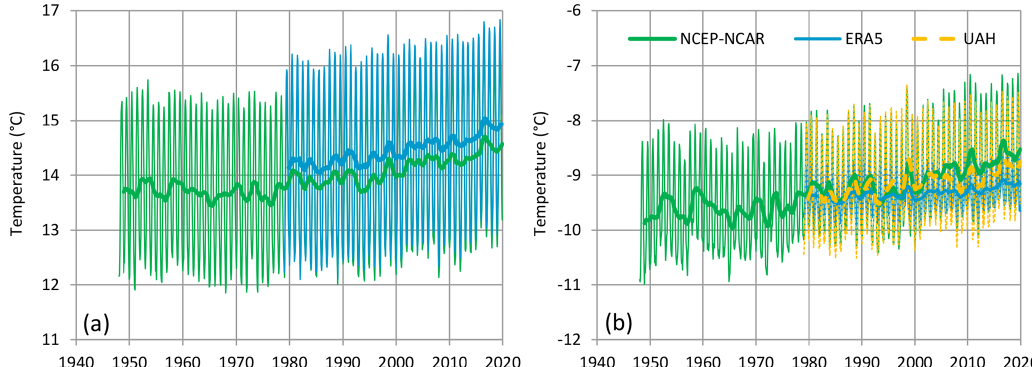
Figure 1. Variation of the global average temperature (a) at the level of 2m above ground and (b) at the lower troposphere. Thin and thick lines of the same colour represent monthly values and running annual averages (right aligned), respectively. Sources of data are indicated in the legend and detailed in Table 1. In panel (b) , the reanalyses (NCEP–NCAR and ERA5) time series are weighted averages of those at the levels of 500 and 700hPa, with weights of 0.62 and 0.38, respectively, which were found for optimal fitting with the satellite (UAH) series. Table 2. Average air temperature ( T ) and dew point ( T d ), in ◦ C per 20-year and 10-year climatic period, and the resulting differences. Data are from the ERA5 reanalysis, except for lower troposphere, which are from UAH. Variable and First Last Difference in First Last Difference in Offset distance, km per decade a domain 20 years 20 years 20 years (and per decade) 10 years 10 years 30 years (and per decade) (offset height, m per decade b ) T ,